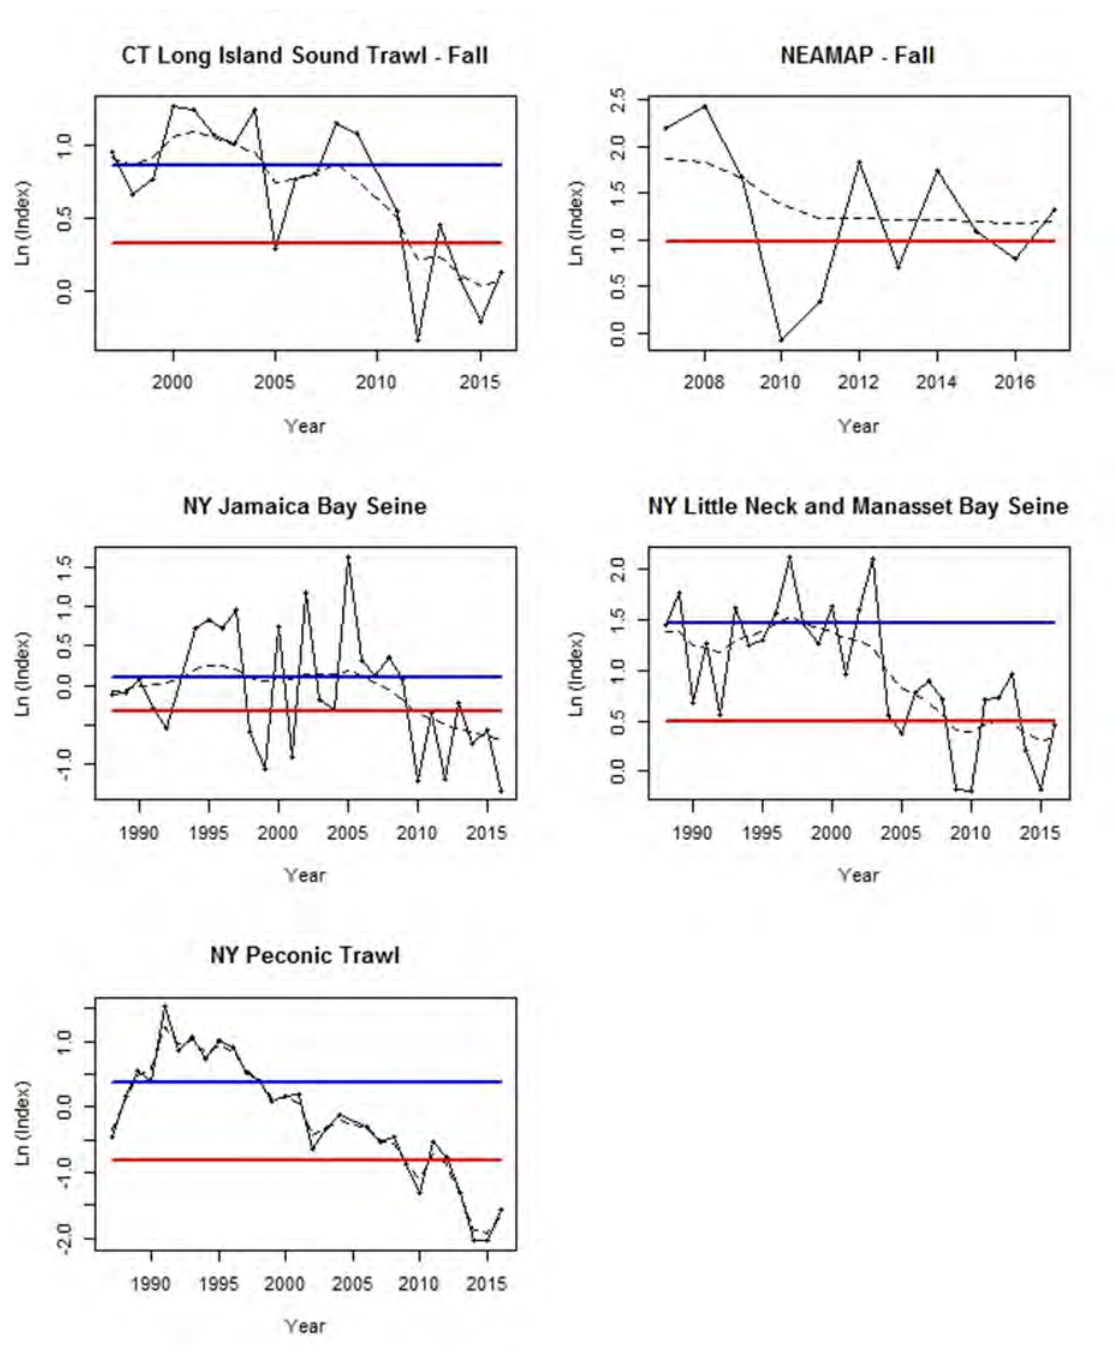
Figure 84. New York Region horseshoe crab survey ARIMA model fits. The solid line represents the observed ln transformed indices and the dashed line represents the fitted indices. The red horizontal line represents the Q 25 reference point and the blue horizontal line represents the 1998 reference